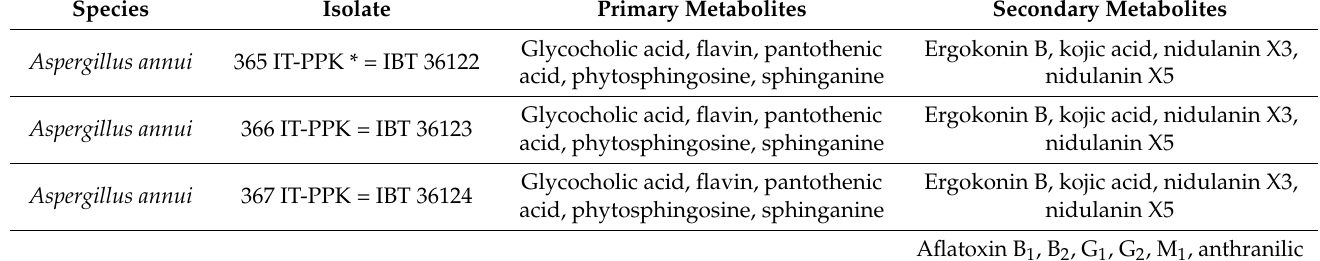
Production of primary and secondary metabolites, including mycotoxins, by Aspergillus annui sp. nov. and A. saccharicola sp.